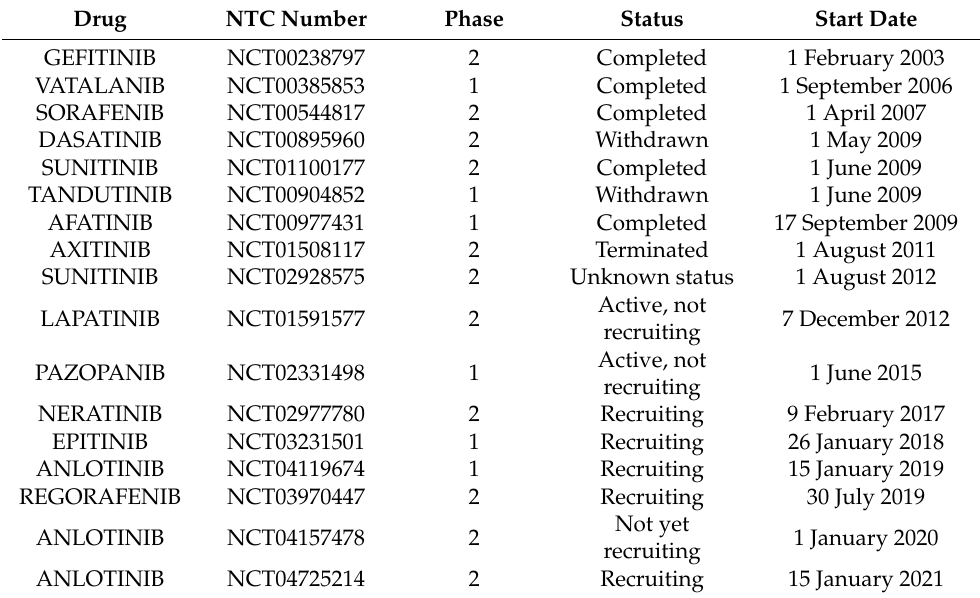
Table 2. Clinical trials of Receptor Tyrosine Kinase Inhibitors in Newly diagnosed Glioblastoma. Drug NTC Number